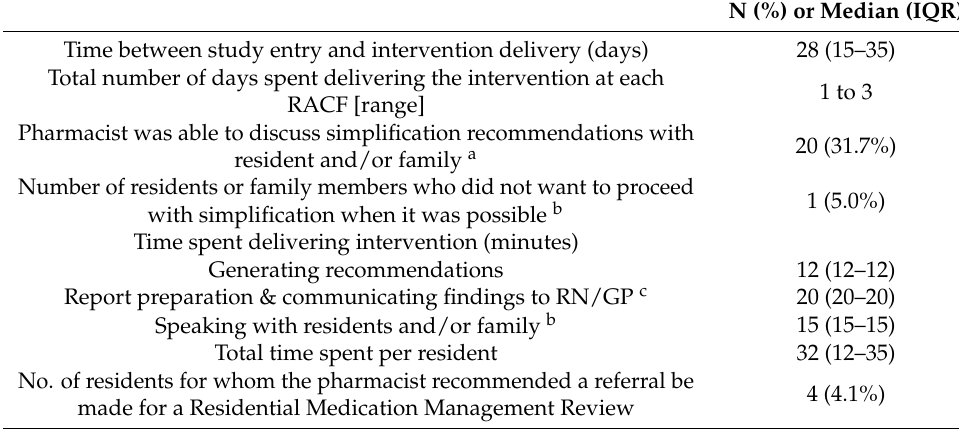
Table 2. Overview of intervention delivery by the clinical pharmacist ( n = 96